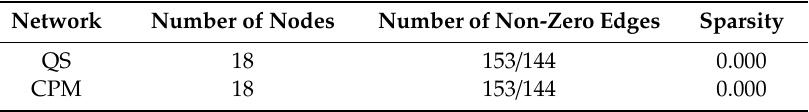
Figure 7. Network plot for quantity surveyor. Table 12. Summary of the